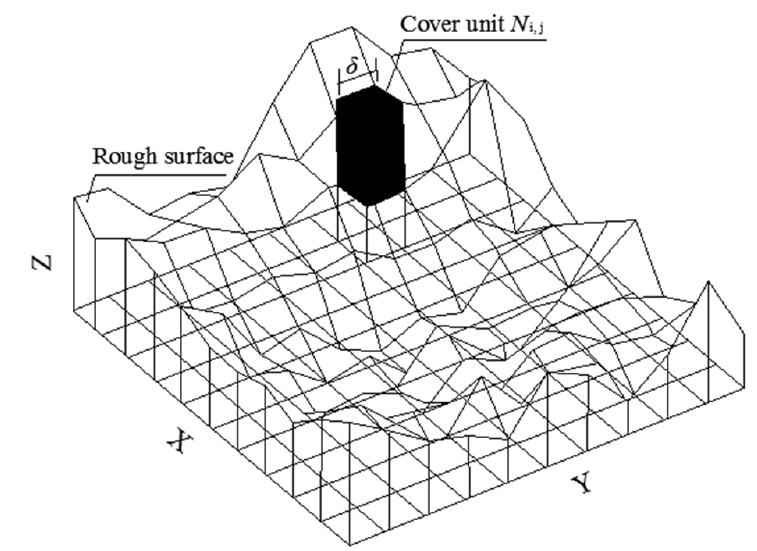
Figure 3. Schematic diagram of box-counting method.